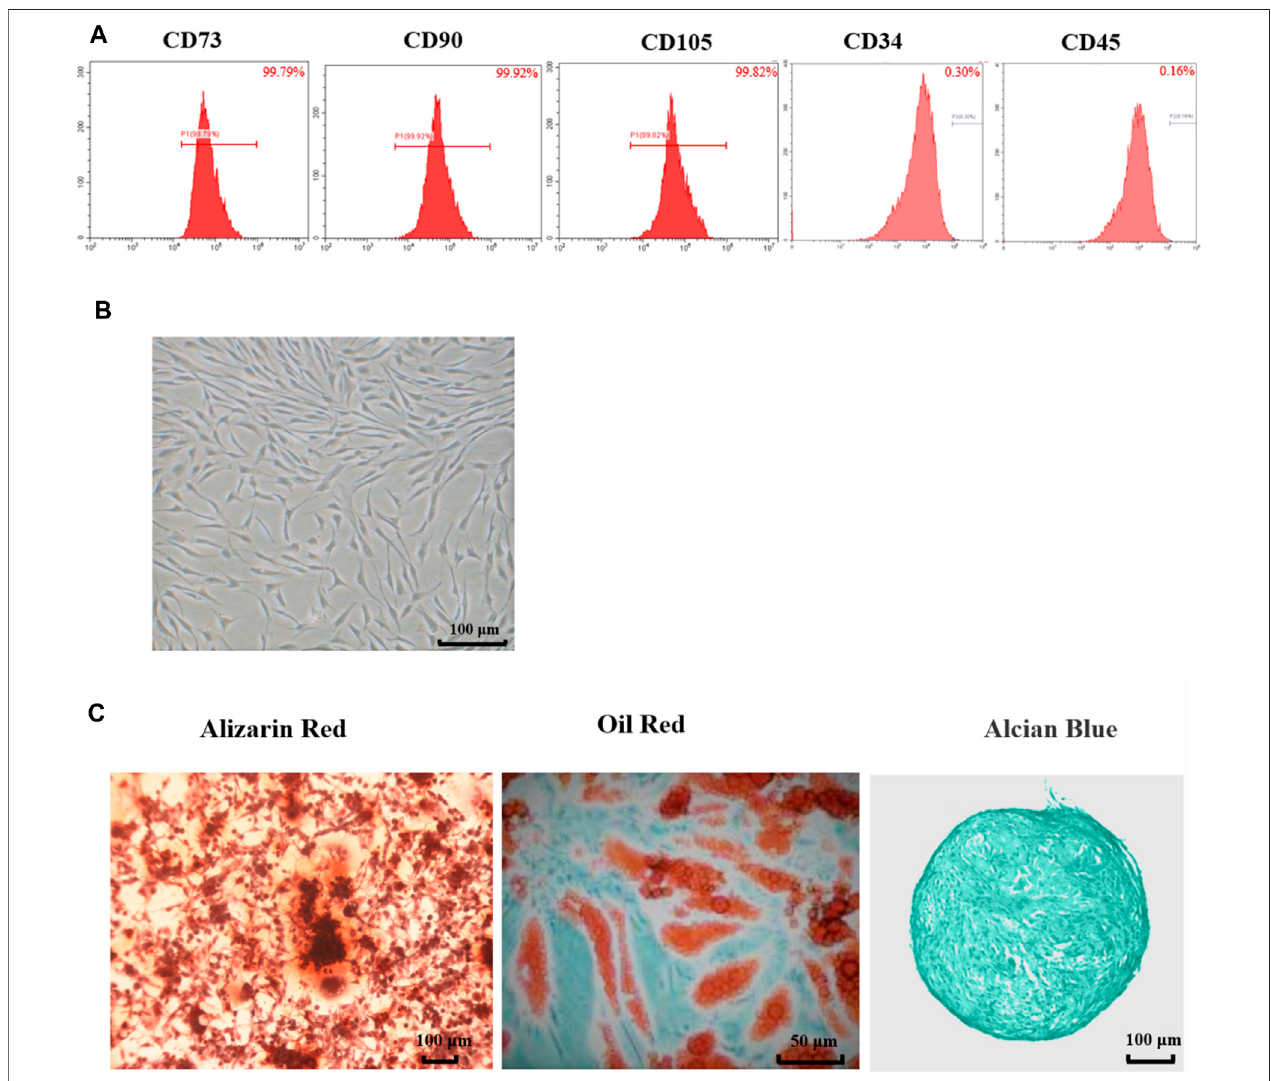
FIGURE 1 | Characteristics of adipose-derived mesenchymal stem cell from rats. (A) Flow cytometry of Ad-MSCs by CD73, CD90, CD105, CD34 and CD45. (B) The morphology of Ad-MSCs. (C) Tri-lineage differentiation capacity of MSCs: stained with Oil Red-O after induction into adipocytes, stained with Alizarin Red after induction into osteocytes and stained with Alcian Blue after induction into